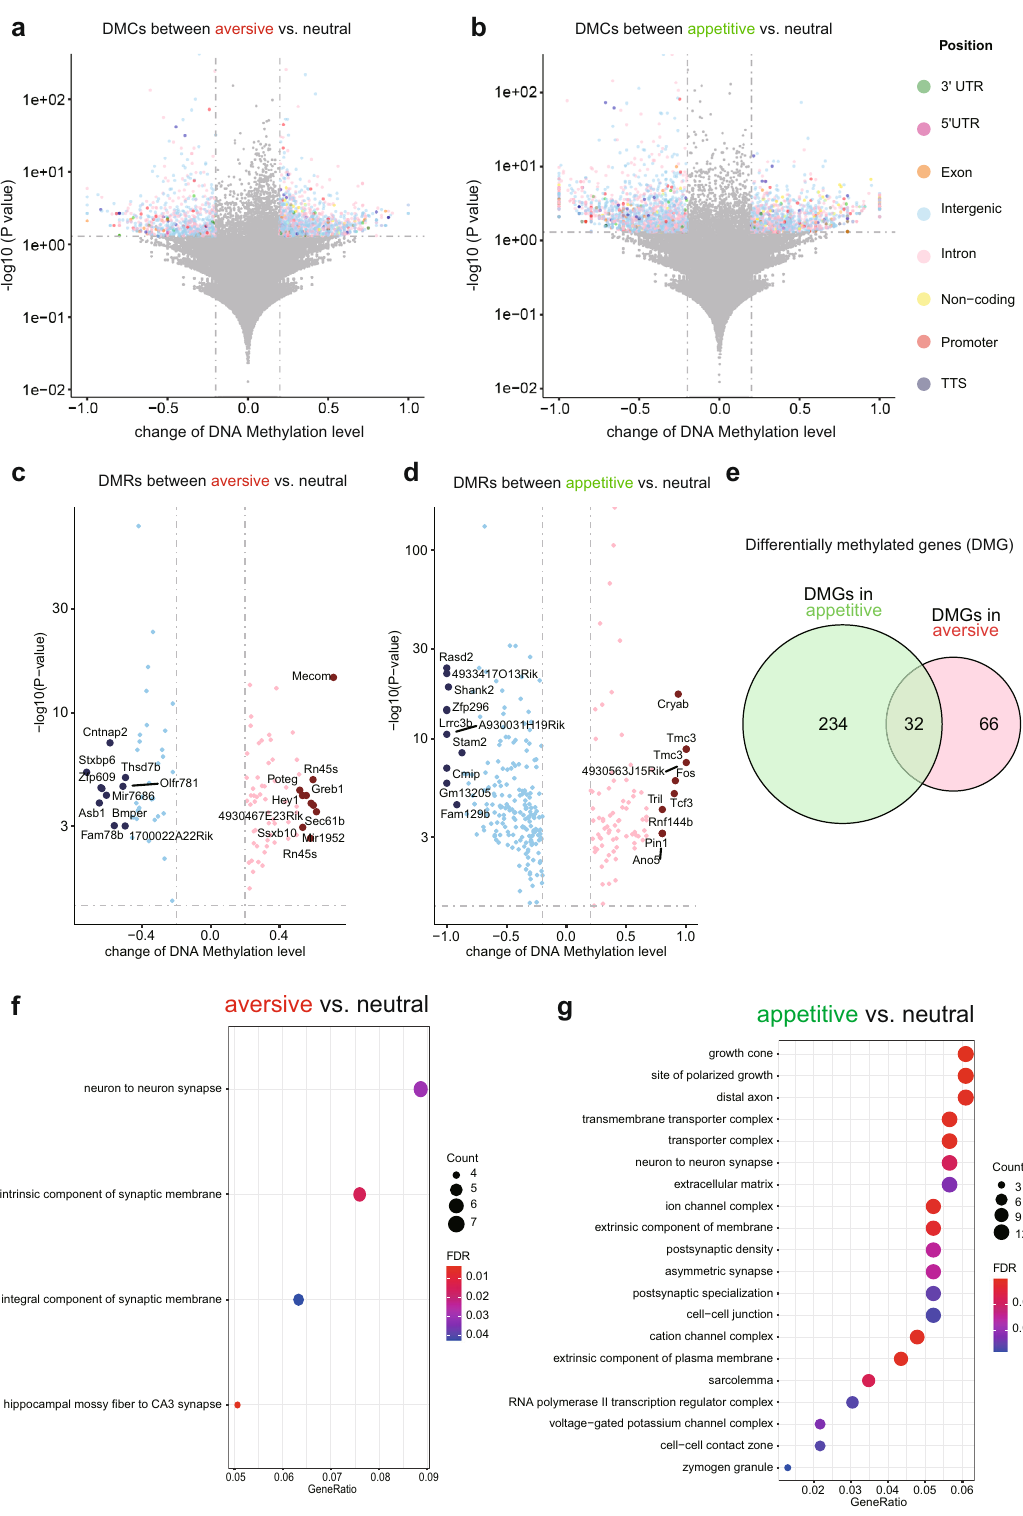
Fig. 5 Distinct DNA methylation landscapes of aversive and appetitive vCA1 cells. Volcano plots showing the differentially methylated cytosines (DMC) with the change of DNA methylation larger than 20% and p value smaller than 0.05 in aversive a , or appetitive b , vCA1 cells compared to the neutral group. DMCs in different genomic positions (3 ’ UTR, 5 ’ UTR, exon, intergenic, intron, non-coding promotor, TSS) are color coded. Volcano plot showing differently methylated regions (DMRs) that contain at least two DMCs for each DMR in aversive c , and appetitive d , vCA1 cells. The top 10 hypermethylated and hypomethylated regions were highlighted in either pink or blue separately and were annotated to its nearest genes. e A Venn diagram showing differently methylated genes (DMGs) that are associated with DMRs in c and d identi fi ed in aversive and appetitive vCA1 cells. f , GO analysis of DMGs in aversive vCA1 cells. g GO analysis of DMGs in appetitive vCA1